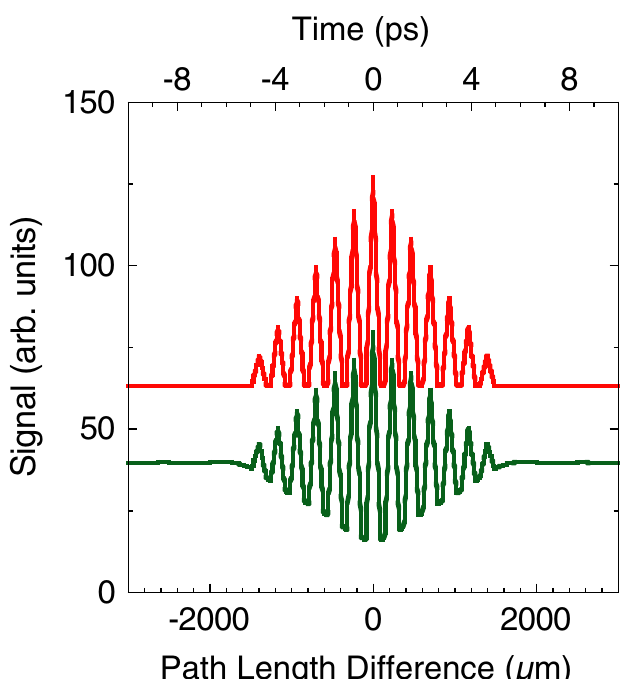
FIG. 10. (Color) CTR interferometer signal calculated using Eq. (12) for the train of six square bunches 208 (cid:8) m wide and with a 344 (cid:8) m spacing with the full electric field (red curve) and including a low-pass filter function that cuts off wavelengths shorter than 1000 (cid:8) m (green curve). The absolute amplitudes are arbitrary, but the relative amplitudes are preserved. The full trace (red curve) has the same features as the expected trace shown in Fig. 8 and the filtered trace (green curve) reproduces the features of the measured signal displayed in Fig. 9.